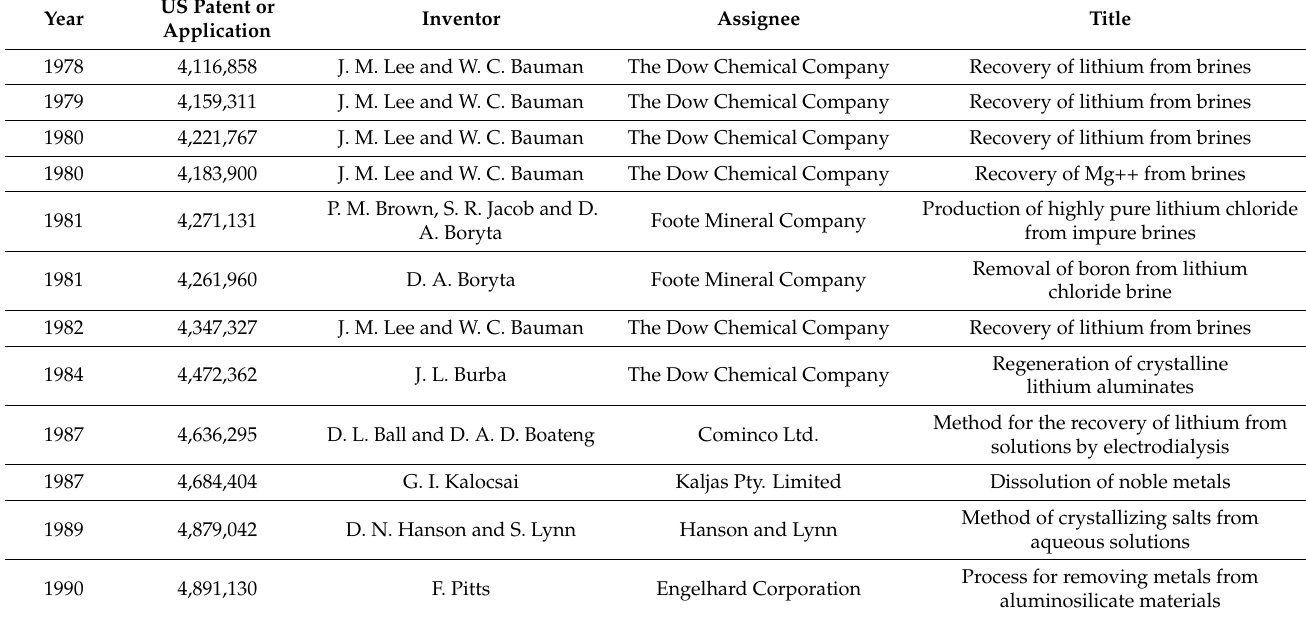
Table 8. Other patents or patent applications associated with the extraction of lithium from